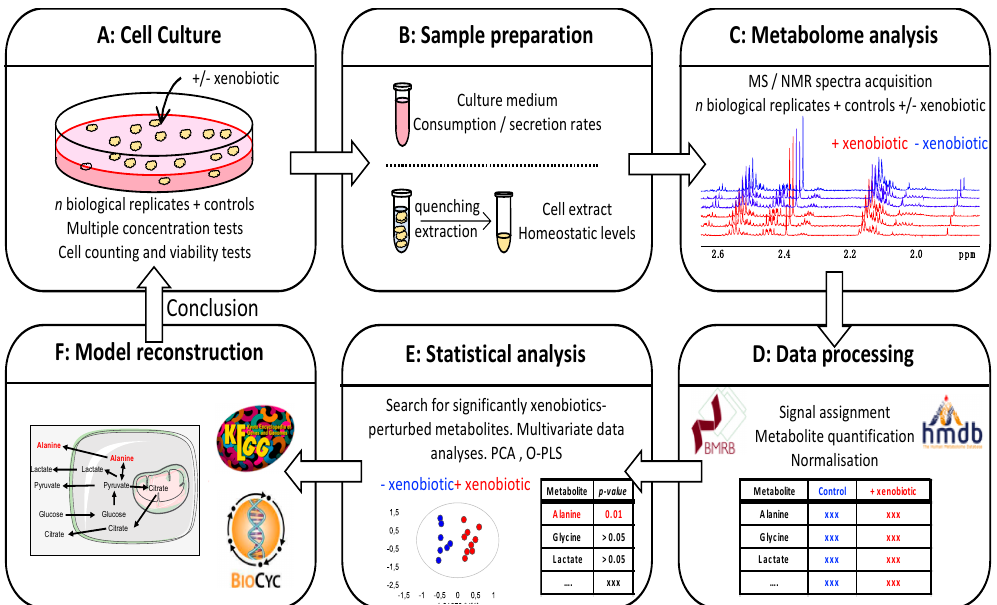
Figure 2. Detection of xenobiotics-induced metabolism alterations in mammalian cell cultures: general metabolomics workflow. ( A ) Cell cultures are performed in the presence of a concentration range of xenobiotic. Adequate controls are used: dishes without cells to determine consumption / secretion rates, dishes for cell counting, as well as biological parameters determination such as viability tests. ( B ) Metabolomics sample preparation: the culture medium that contains extracellular metabolites is isolated by centrifugation; the cell pellet is subjected to metabolism quenching and metabolite extraction protocols to extract the intracellular metabolites. ( C ) The metabolome analysis by MS and / or NMR data acquisition allows for the obtaining of rich experimental data. ( D ) Data processing, metabolite identification, quantification, and normalization of the results. ( E ) Statistical analyses to identify metabolites levels that are altered as a consequence of xenobiotic testing (this step aims to identify individual biomarkers as well as complex metabolites signatures). ( F ) Model reconstruction and integration of the results over metabolic pathways.